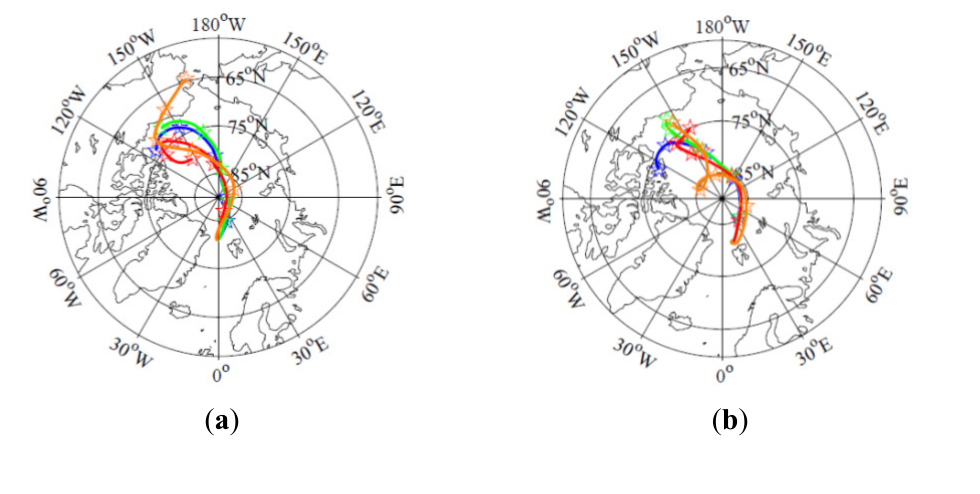
Figure 14. Correlation PEP mean backward trajectories calculated from ensemble trajectories along the flight track on 5 April 2009 at 13:38 ( a ), on 6 April 2009 at 12:43 ( b ), and on 10 April 2009 at 14:02 ( c ) and 16:02 UTC ( d ). The ensembles consist of a set of trajectories with starting positions distributed around the point of interest (here the aircraft location at a given time) in uniform density. The colors represent the pressure levels, 950 hPa (blue), 850 hPa (green), 700 hPa (red) and 500 hPa (orange). Stars are set for every day. On 5 and 6 April, backward trajectories are calculated for six days. On 10 April, trajectories are calculated for 12 days. Stars are set for every two